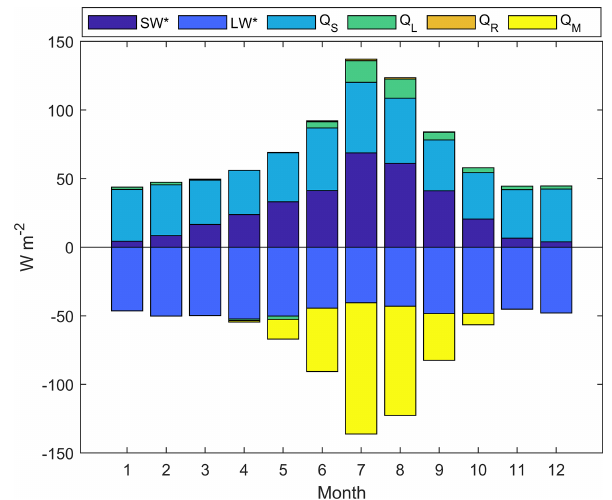
Figure 9. Mean seasonal cycle of simulated surface energy balance on Saskatchewan Glacier between 1979–2016 from the multitempo- ral DEM simulation. SW ∗ : net shortwave radiation; LW ∗ : net long- wave radiation; Q S : sensible-heat flux; Q L : latent-heat flux; Q R : rainfall heat flux; Q M : energy used for